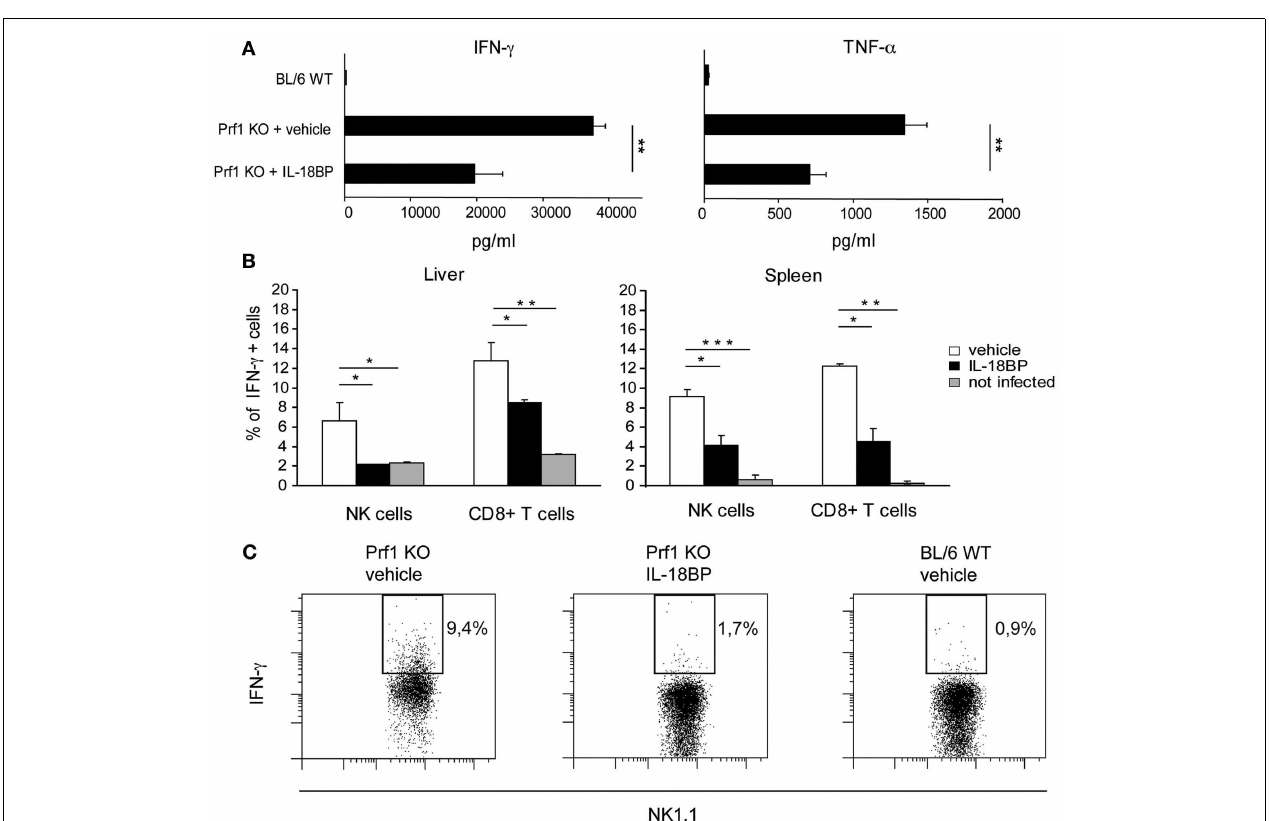
liver and spleen of Prf1 KO mice 6days after MCMV infection. Results are expressed as mean ± SEM of four mice per group. * p < 0.05; **, p < 0.01; *** p < 0.001. (C) Representative flow cytometric analysis of IFN- γ expression by liver NK cells from vehicle treated Prf1 KO mouse, IL-18BP treated Prf1 KO mouse, BL/6WT mouse, 6days after MCMV